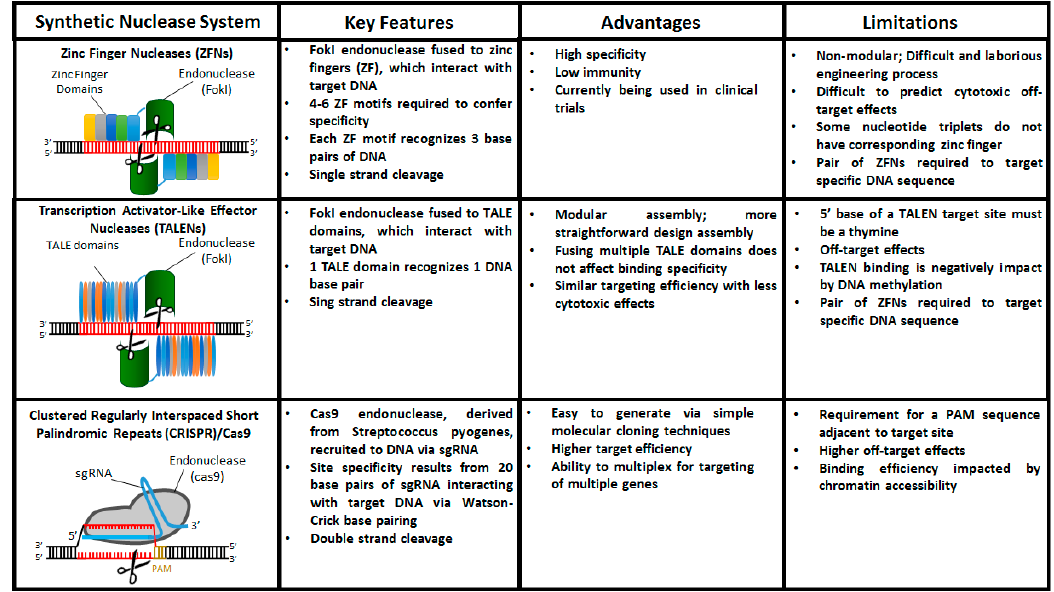
Figure 2. Comparison of engineered nucleases used for targeted gene editing in hiPSCs.